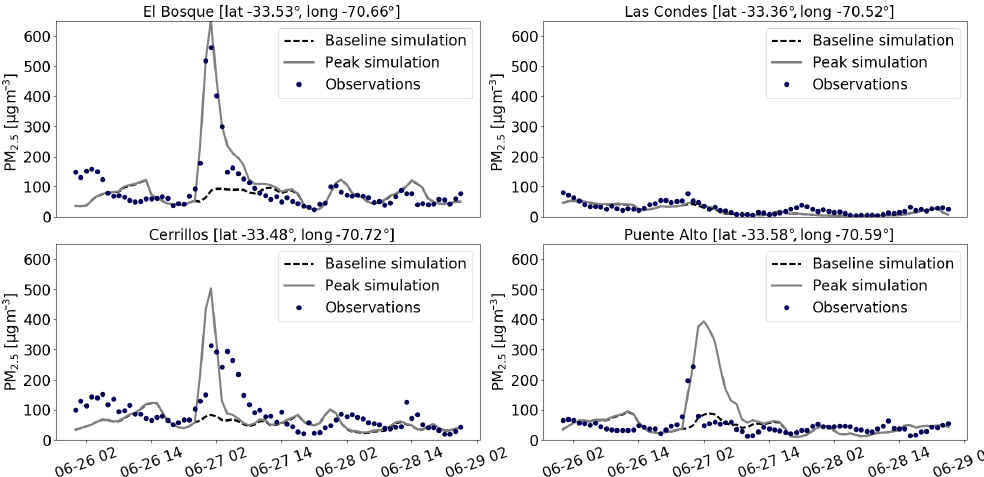
Figure 10. Observed (blue dots) and simulated (baseline simulation is dashed black line; peak simulation is gray line) PM 2 . 5 surface con- centrations time series at four stations in Santiago around the peak episode of 26 June 2016.